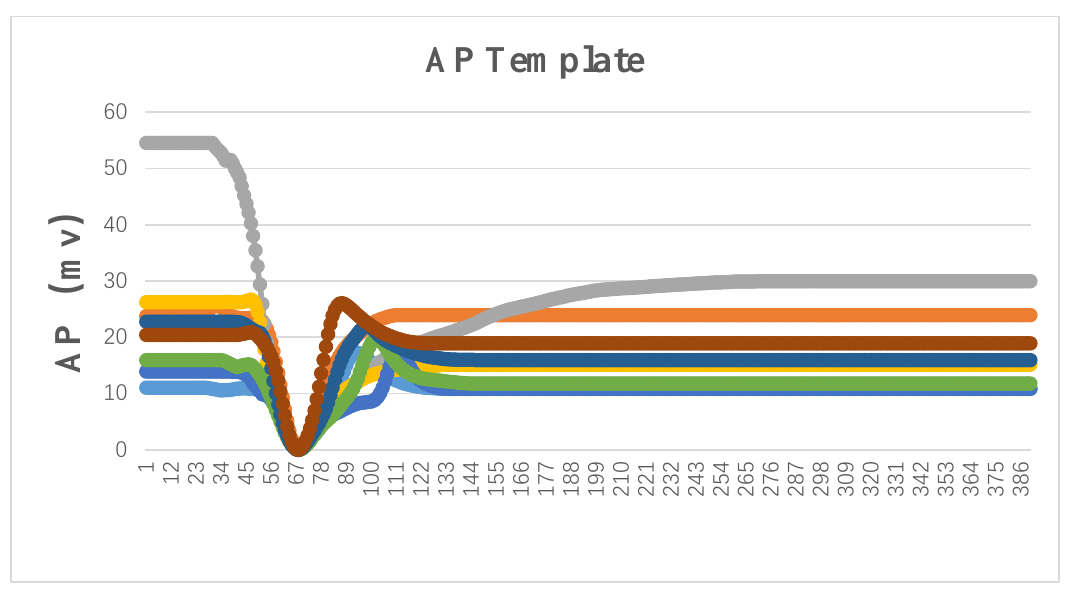
Figure 13. Template Data.